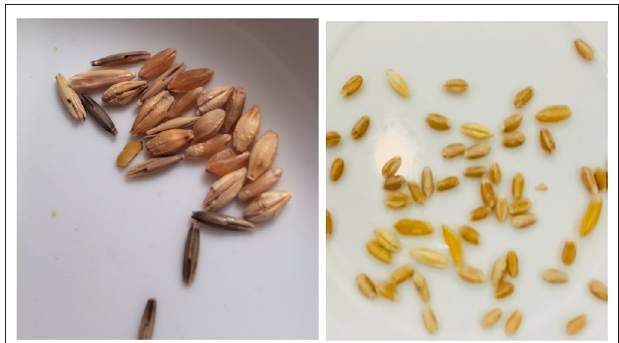
FIGURE 1 | Errant grain found in two different brands of labeled gluten-free lentils later recalled by FDA. Photo credit (left) Kathleen Warthen.